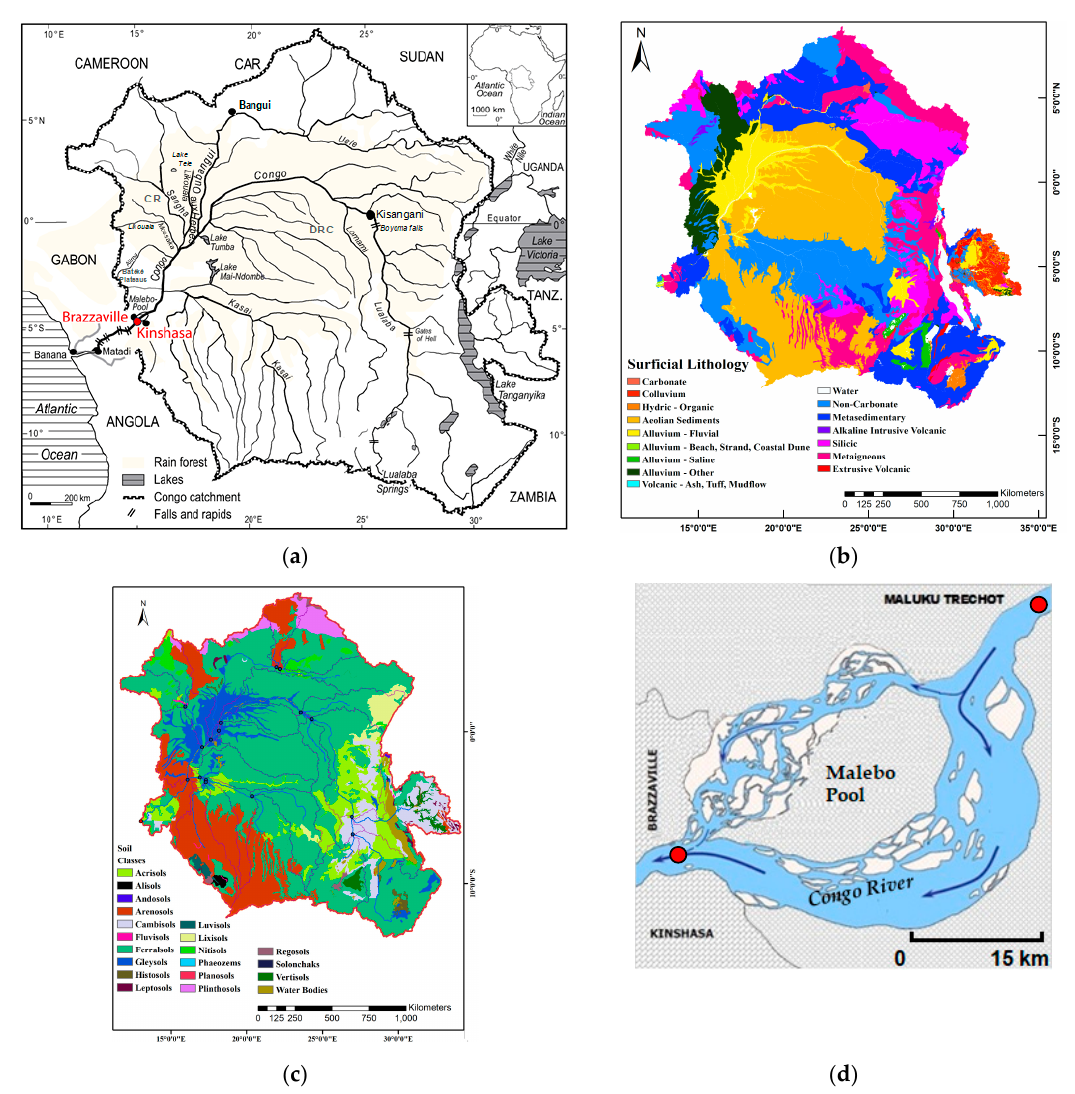
Figure 1. Introduction to the study site: ( a ) Overview of the Congo River Basin (adapted from Runge, 2007 [42]), ( b ) geology, ( c ) soil, and ( d ) Malebo Pool; the 2 dots represent the sampling station of the PEGI/GBF program in the upper part, and the sampling station of the SO/HYBAM program in the lower part .